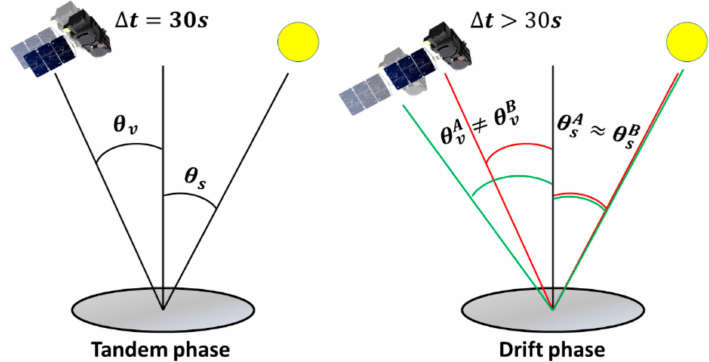
Figure 1. Sketch of the di ff erences between tandem and drift phase geometry. Sentinel-3 platform image by SkywalkerPL (https: // commons.wikimedia.org / w / index.php?curid =